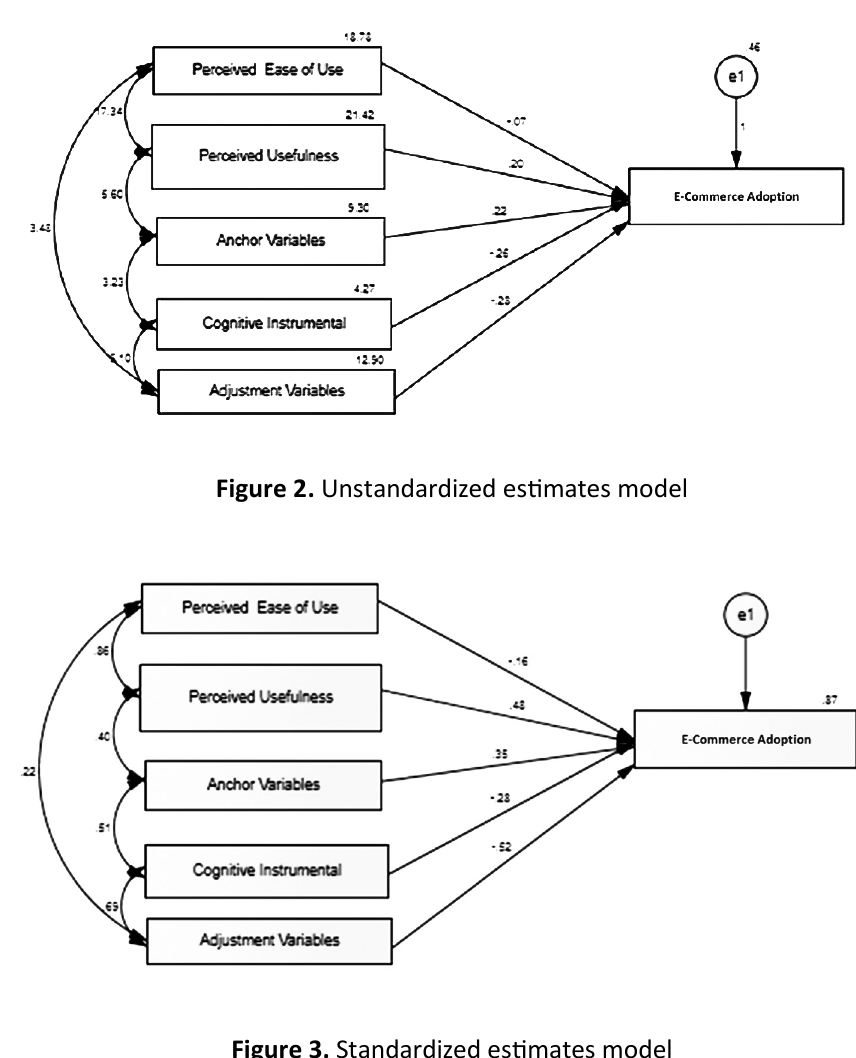
Figure 3. Standardized estimates